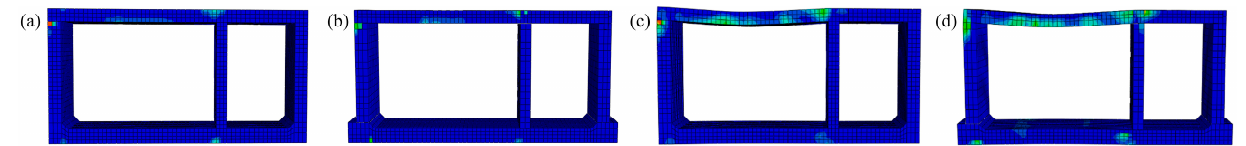
Figure 16. Crack profiles of cast-in-place and prefabricated underground utility tunnels: ( a ) cracking cracks of cast-in-place underground utility tunnel; ( b ) cracking cracks of prefabricated underground utility tunnel; ( c ) failure cracks of cast-in-place underground utility tunnel; and ( d ) failure cracks of prefabricated underground utility tunnel.